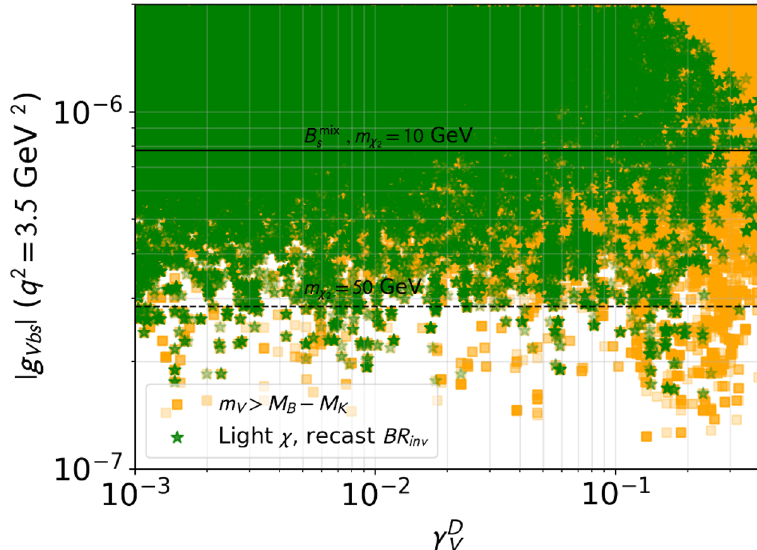
Figure 5 . Results of the scan in the high-mass region, m V = 2 (cid:0) 15 GeV, in the plane of the e(cid:11)ective coupling j g V bs j at q 2 = 3 : 5 GeV 2 versus (cid:13) D . All points in the plot satisfy the (cid:13)avour V constraints at 2 (cid:27) . Yellow squares have m V > M B (cid:0) M K by default, while green stars lie on a broader mass range but must survive the B ! K + inv. limit. The latter is obtained from our recasting procedure assuming V has a (cid:24) 100% decay rate into a light dark fermion with m (cid:31) (cid:28) ( M B (cid:0) M K ) = 2. 0 Horizontal grey lines represent the upper bound from B s mixing on the e(cid:11)ective coupling, under the assumption y 1 (cid:3) y 1 + y 2 (cid:3) y 2 = 0 for two di(cid:11)erent mass values of the compensating dark s s b b